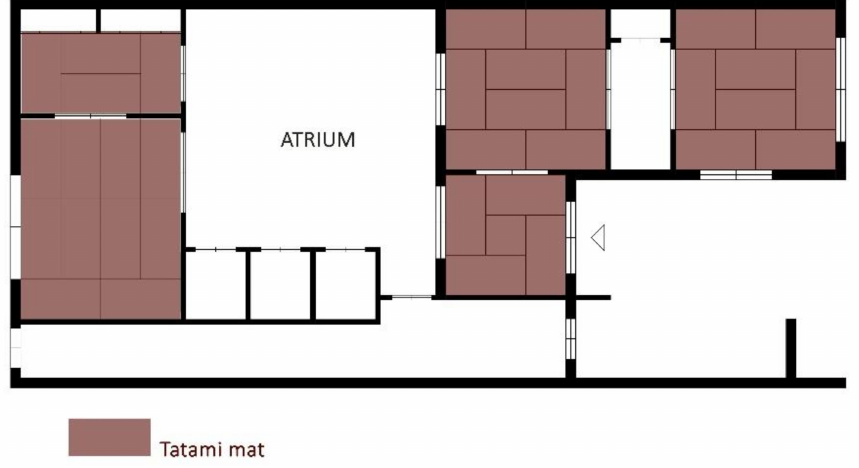
Figure 3. An example of a Japanese traditional